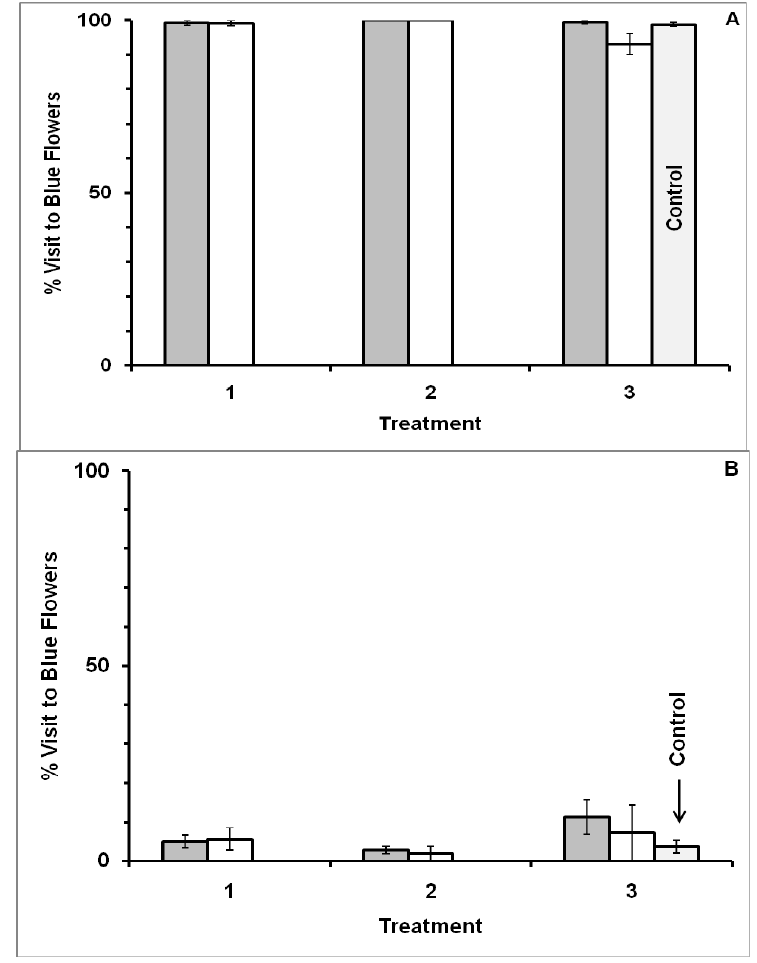
Figure 4. Visitation by bees to blue-yellow dimorphic flower patches in Experiment II. Flower shape as well as reward odor, site location and time differed between morning and afternoon flower patches. Percentage of blue flowers visited is presented for blue forager-type bees in Panel ( A ) (N = 8 bees), and for yellow forager-type bees in Panel ( B ) (N = 7 bees). Error bars indicate ±1 SE. Bar color is by flower color offering the higher molar sucrose reward in Treatment 2: gray bars = bees given the higher molar reward in blue flowers, and white bars = bees given the higher molar reward in yellow flowers. Treatment 1: morning patch, flat flowers with clove scent, with both blue and yellow flowers offering the same reward. Treatment 2: morning patch, flat flowers with clove scent, with reward difference between blue and yellow flowers. Treatment 3: afternoon patch, tube flowers with peppermint scent, with both blue and yellow flowers offering the same reward. Control represents bees that had never visited the morning patch, and thus never experienced Treatments 1 and 2 (N = 12